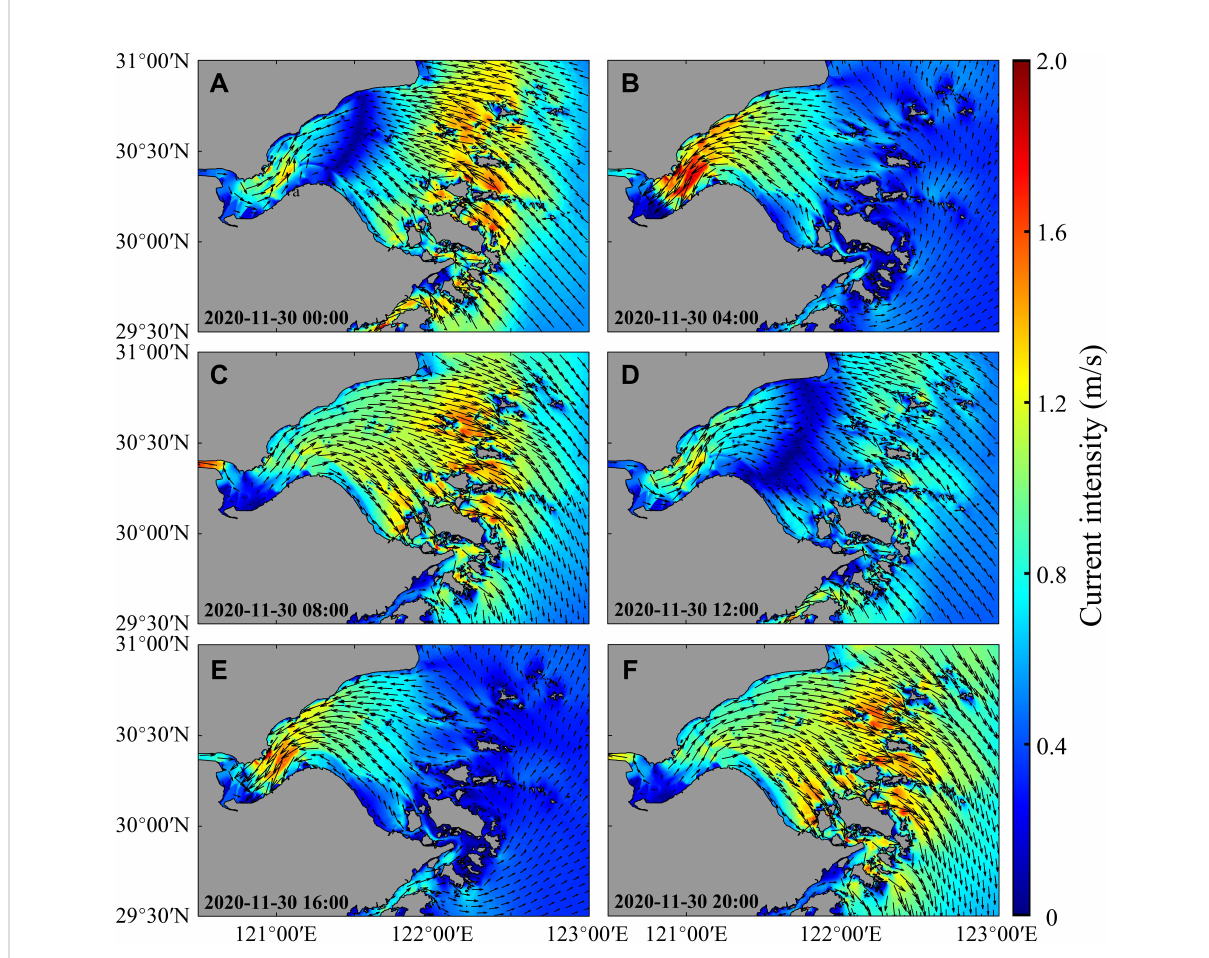
FIGURE 12 Distribution of currents on the sea surface of Zhoushan archipelago on November 30, 2020. (A) 00:00; (B) 10 m wind at the sea surface; (C) SSS. (A – F) Distribution of currents at 00:00, 04:00, 08:00, 12:00, 16:00, and 20:00, divided by four-hourly intervals.